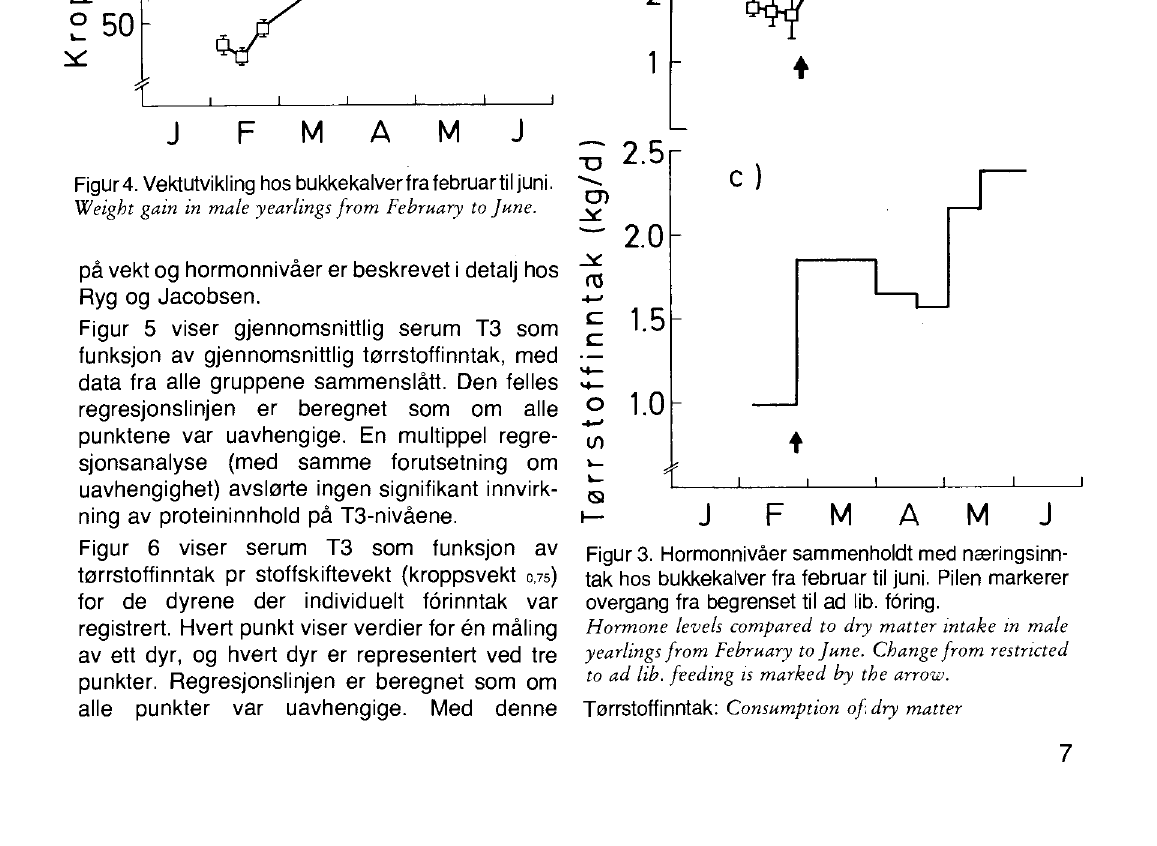
Figur 4. Vektutvikling hos bukkekalver fra februar til juni. Weight gain in male yearlings from February to June. på vekt og hormonnivåer er beskrevet i detalj hos Ryg og Jacobsen.